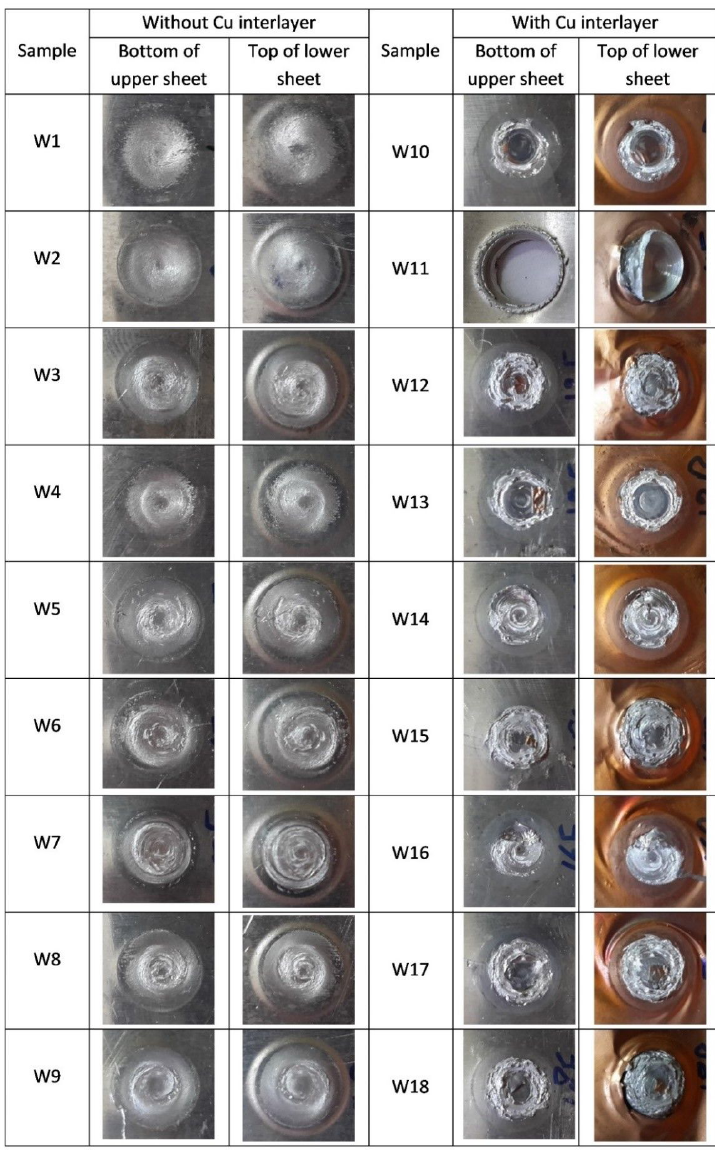
Figure 10: Fractographic views of tensile-shear P-FSSW joint